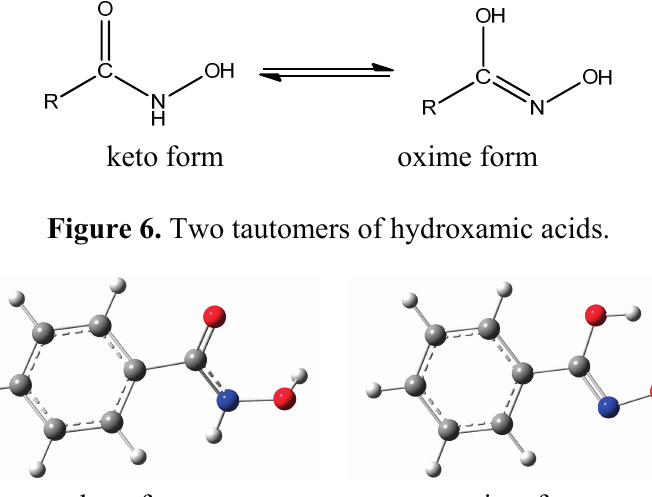
keto form oxime form Figure 7. Optimized molecular geometries of oxime form and keto form for benzohydroxamic acid (BHA). Table 3. The calculated total energy of BHA in different